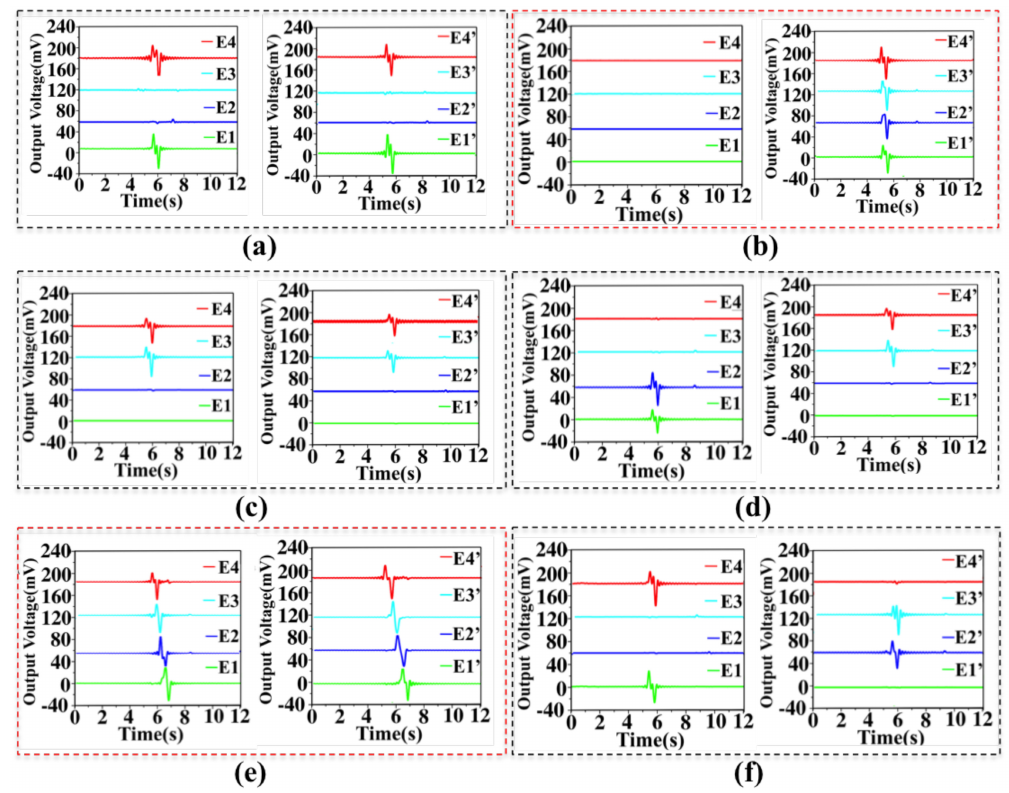
Figure 8. The operating mode and voltage output of the sensor. Voltage output of sensor corresponding to moving along X direction ( a ), Y direction ( b ), Z direction ( c ) and revolving around the X axis ( d ), Y axis ( e ), Z axis ( f ),